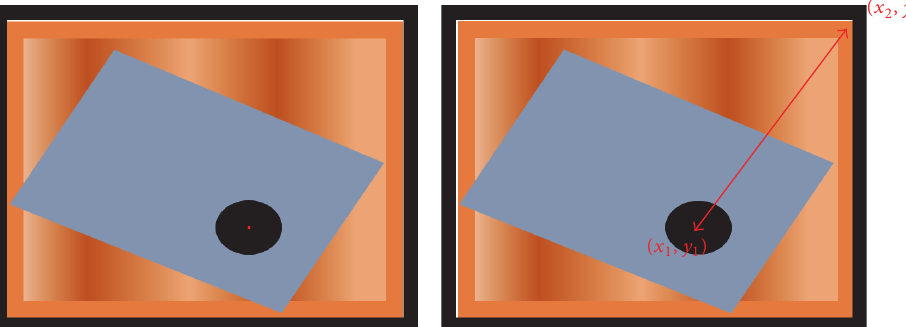
Figure 6: Distance to find in scaling.